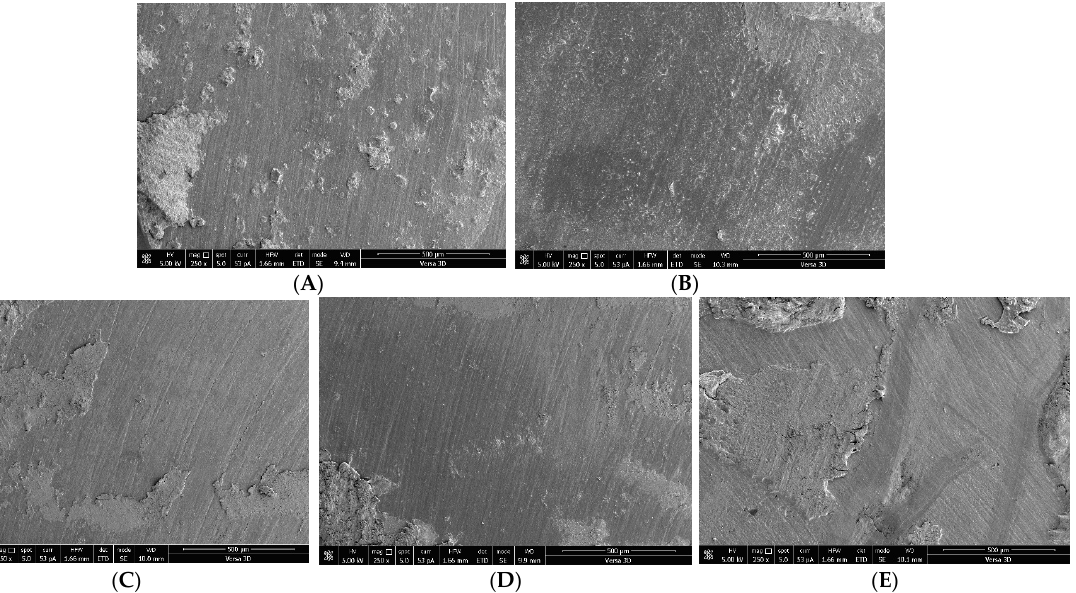
and ( E ) group Figure 2. SEM pictures of mixed failure pattern : ( A ) group 3; ( B ) group 6; ( C ) group 7; ( D ) group 8; and ( E ) group 9 .